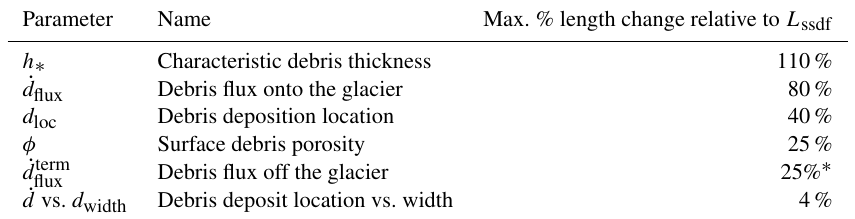
Table 2. Sensitivity of steady state glacier length to changes in debris-related parameters.